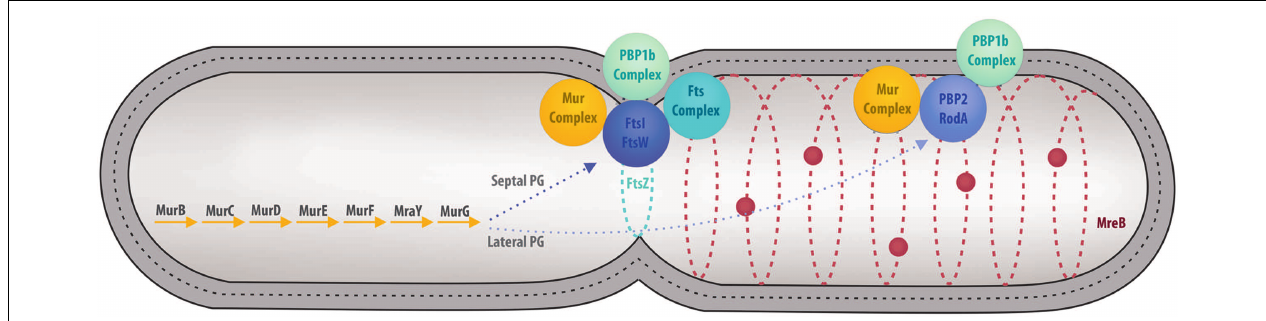
FIGURE 3 | Overview of cell division in model organisms. Major cell division and PG synthesis complexes are represented. Cytoplasmic steps of PG synthesis enzymes (Left) , major cell division and septal PG synthesis complexes (Center) , and elongation of lateral PG complexes (Right) are represented by colored spheres. PG is represented by a dotted line between the inner and outer